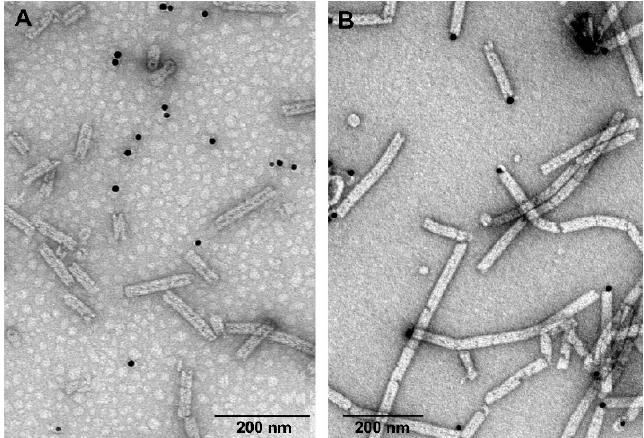
Figure 9. Electron micrographs of the polysheaths formed by the purified recombinant gp053 incubated with the neutravidin-conjugated gold nanoparticles. ( A ) Non-modified gp053, and ( B ) gp053-harbouring cysteines modified with biotin.